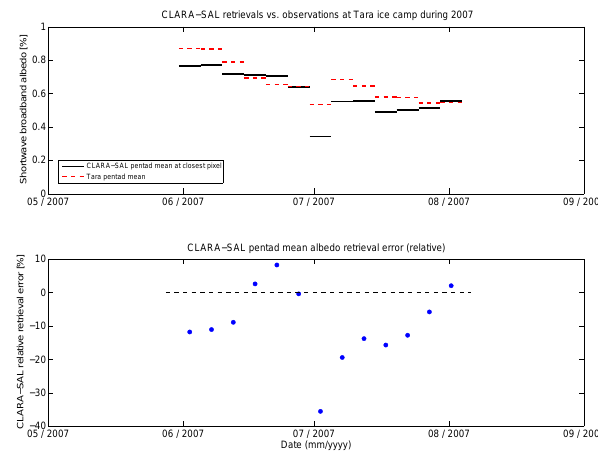
Fig. 7. Same as Fig. 6, but for Tara ice camp data from 2007.